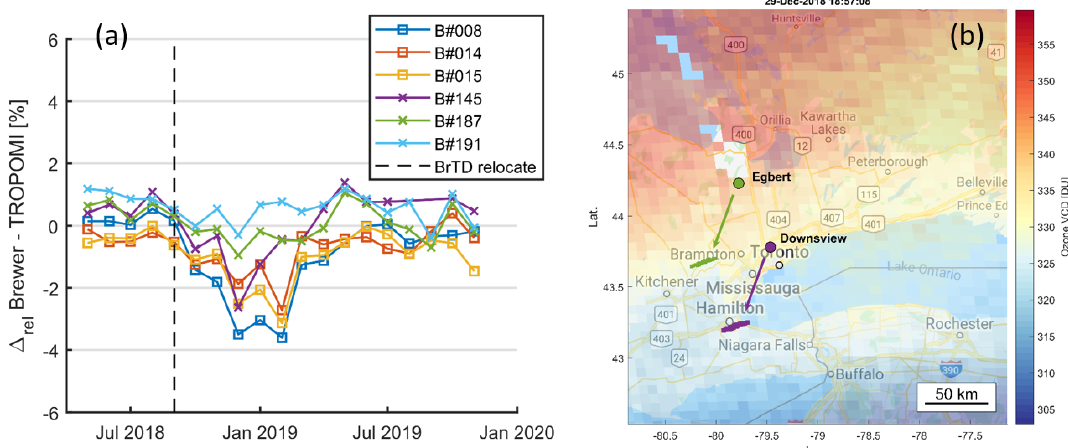
Figure 9. Example of small-scale column ozone field variation. (a) Monthly relative differences between Brewers and TROPOMI total column ozone overpass measurements (for Downsview in Toronto) and (b) TROPOMI total column ozone measured on 29 December 2018 over southern Ontario, masked with Brewers’ viewing directions and sampling areas. The base map is from © Google